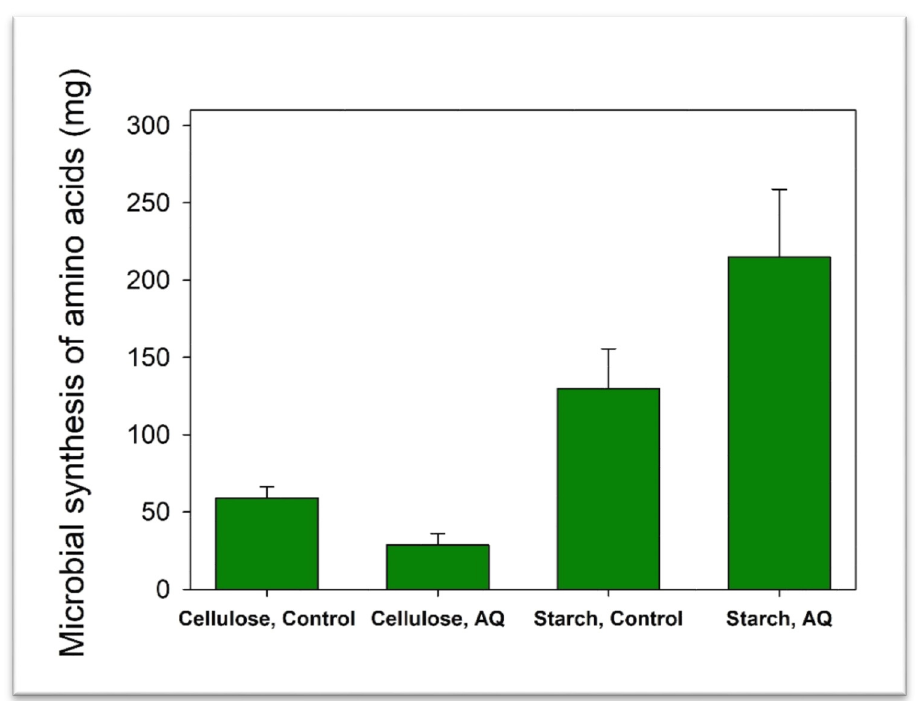
Figure 1. Net de novo synthesis of microbial amino acids in mixed rumen batch cultures growing on cellulose or starch with functional methanogenesis (Control) or with methanogenesis inhibited by 9, 10-anthraquinone (AQ), depicting an interaction ( p < 0.05) between methanogenesis inhibition and the energy and carbon substrate.